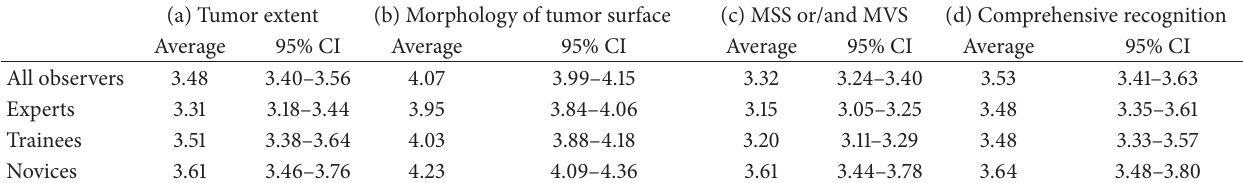
Table 4: The degree of certainty of Study